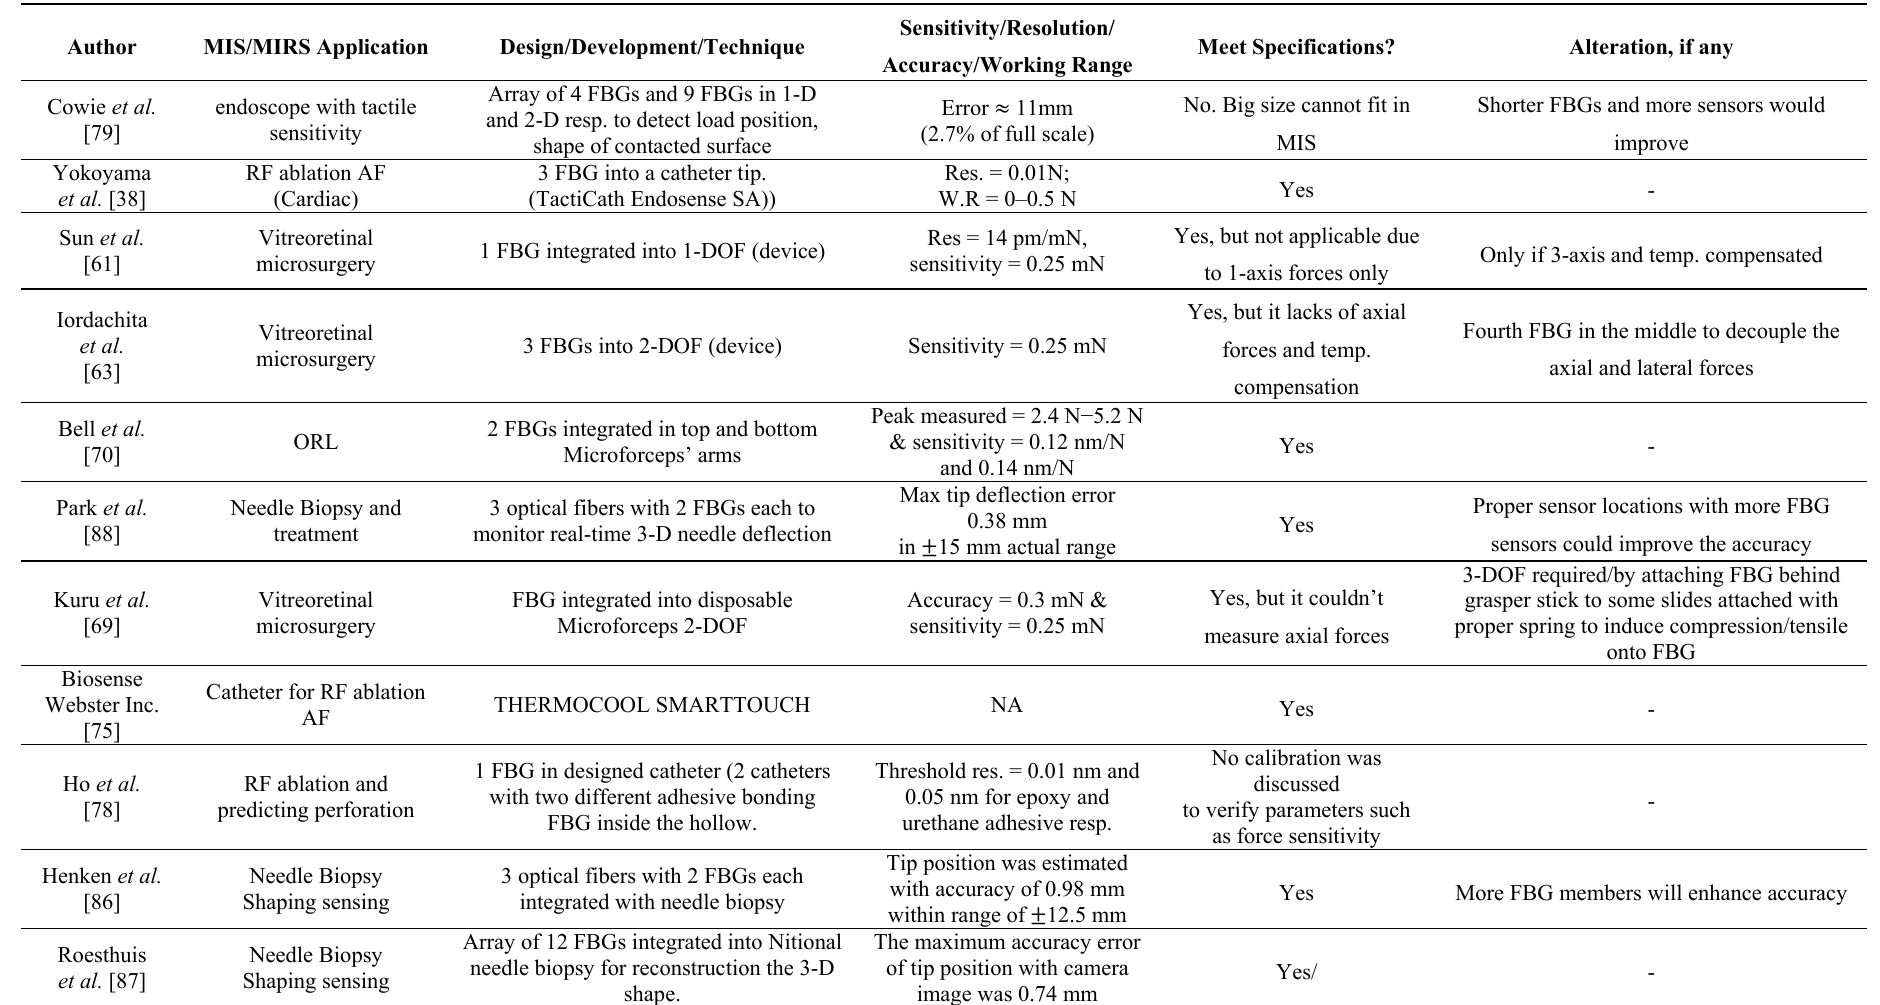
Table 4. Summary for FBGs tactile force sensor in